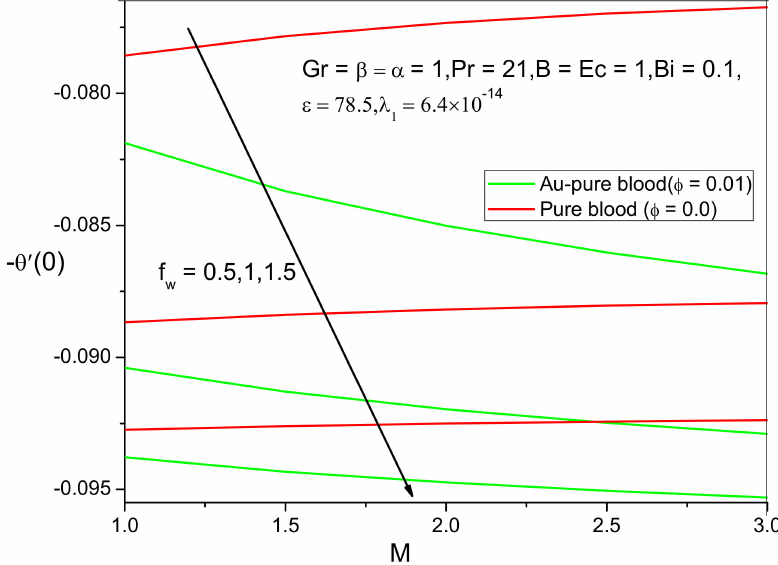
Figure 23. Local Nusselt number − θ (cid:48) ( 0 ) with M for different values of f w